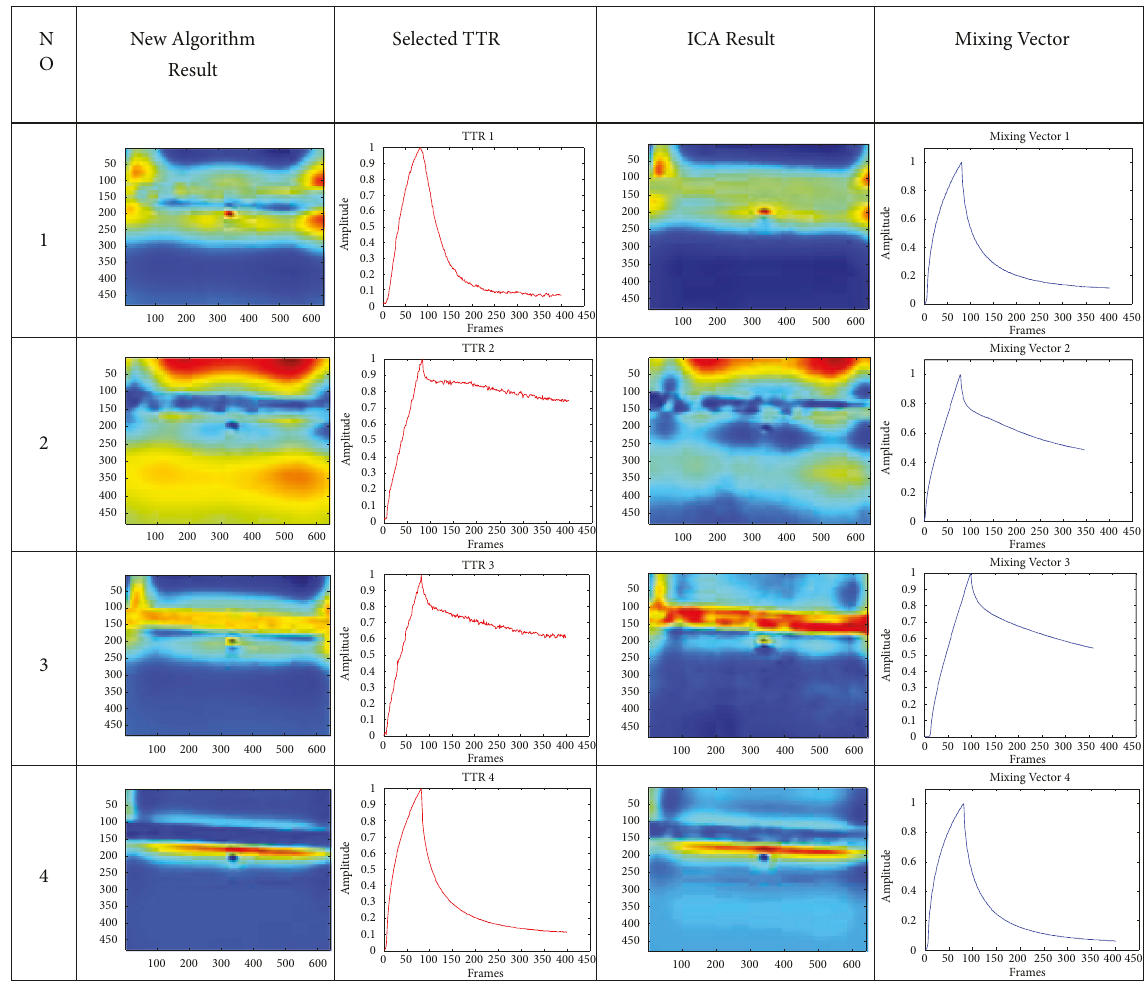
Figure 11: The proposed algorithm and ICA result of sample 1.